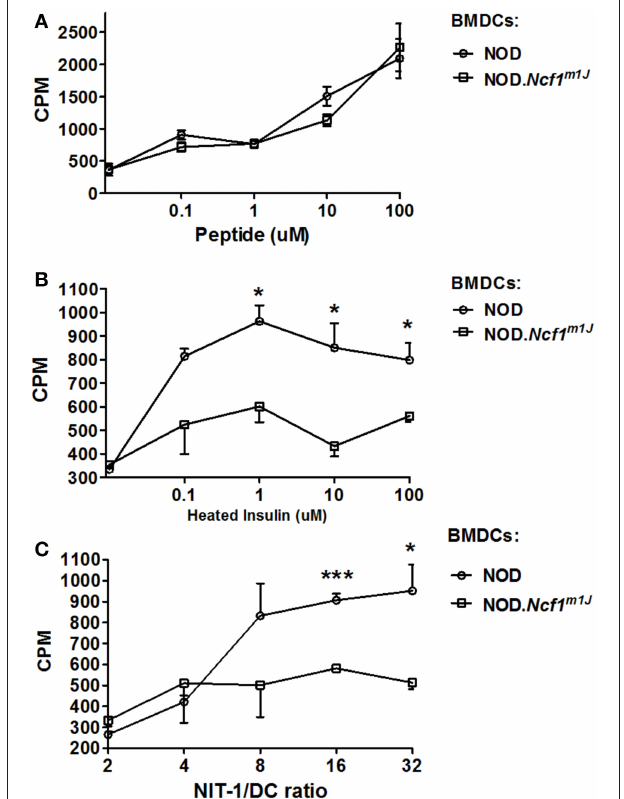
FIGURE 7 | Cross-priming of autoreactive CD8 + T cells by DCs. (A) Proliferation of G9C8 cells induced by BMDCs from NOD or NOD- Ncf1 m1J pulsed with insulin peptide B15-23. (B) Proliferation of G9C8 cells induced by BMDCs from NOD or NOD- Ncf1 m1J pulsed with heat-inactivated insulin. (C) Proliferation of G9C8 cells induced by necrotic NIT-1 cell pulsed BMDCs. Graphs are representative of three independent experiments performed in triplicate. Data are represented as mean ± SEM. Statistical analysis used Student’s t -test. * p < 0.05; *** p <